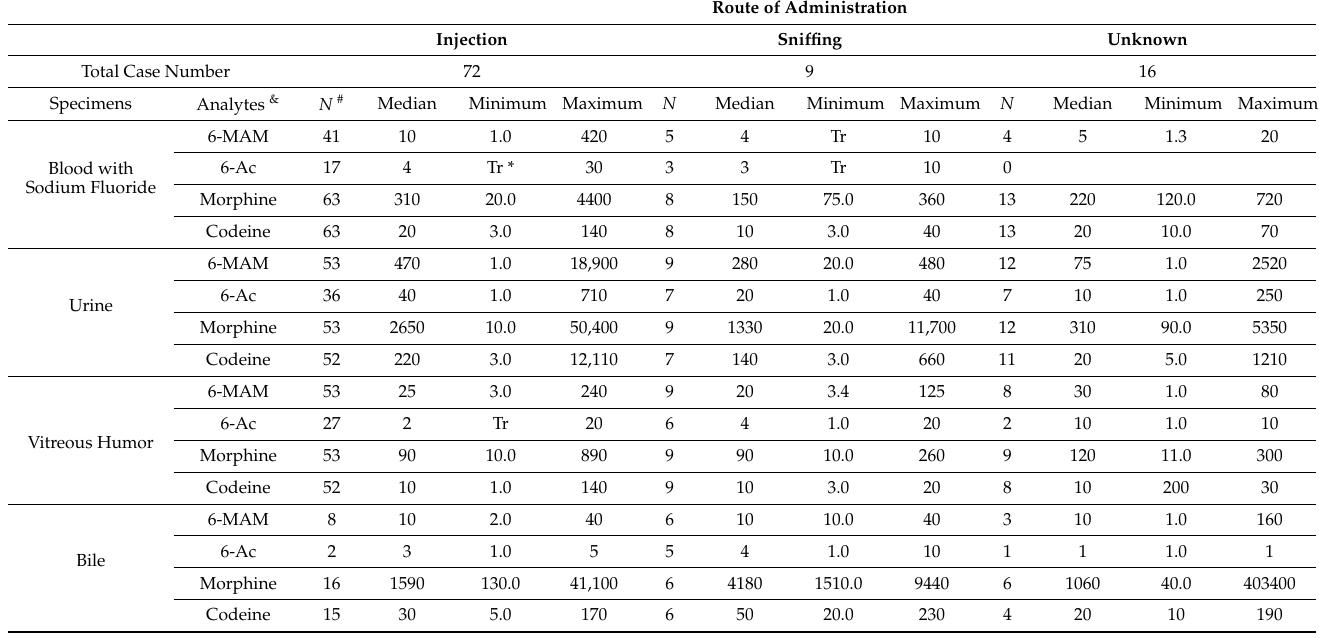
Table 5. Comparison of different routes of administration on heroin biomarkers, morphine,